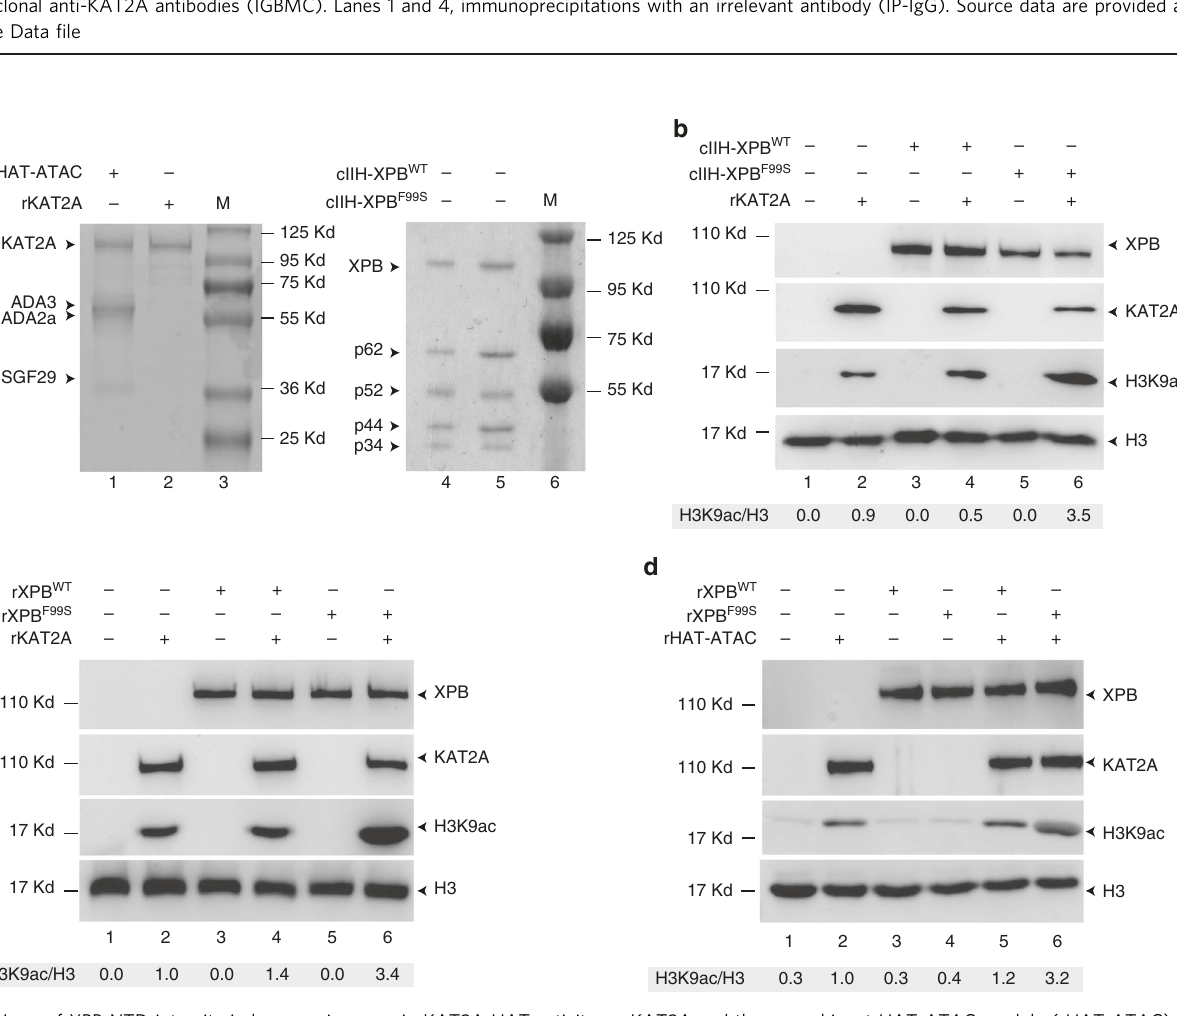
Fig. 3 XPB recruits KAT2A-containing HAT complexes to chromatin. a TFIIH-XPB WT was immunoprecipitated from nuclear extracts of stably transfected